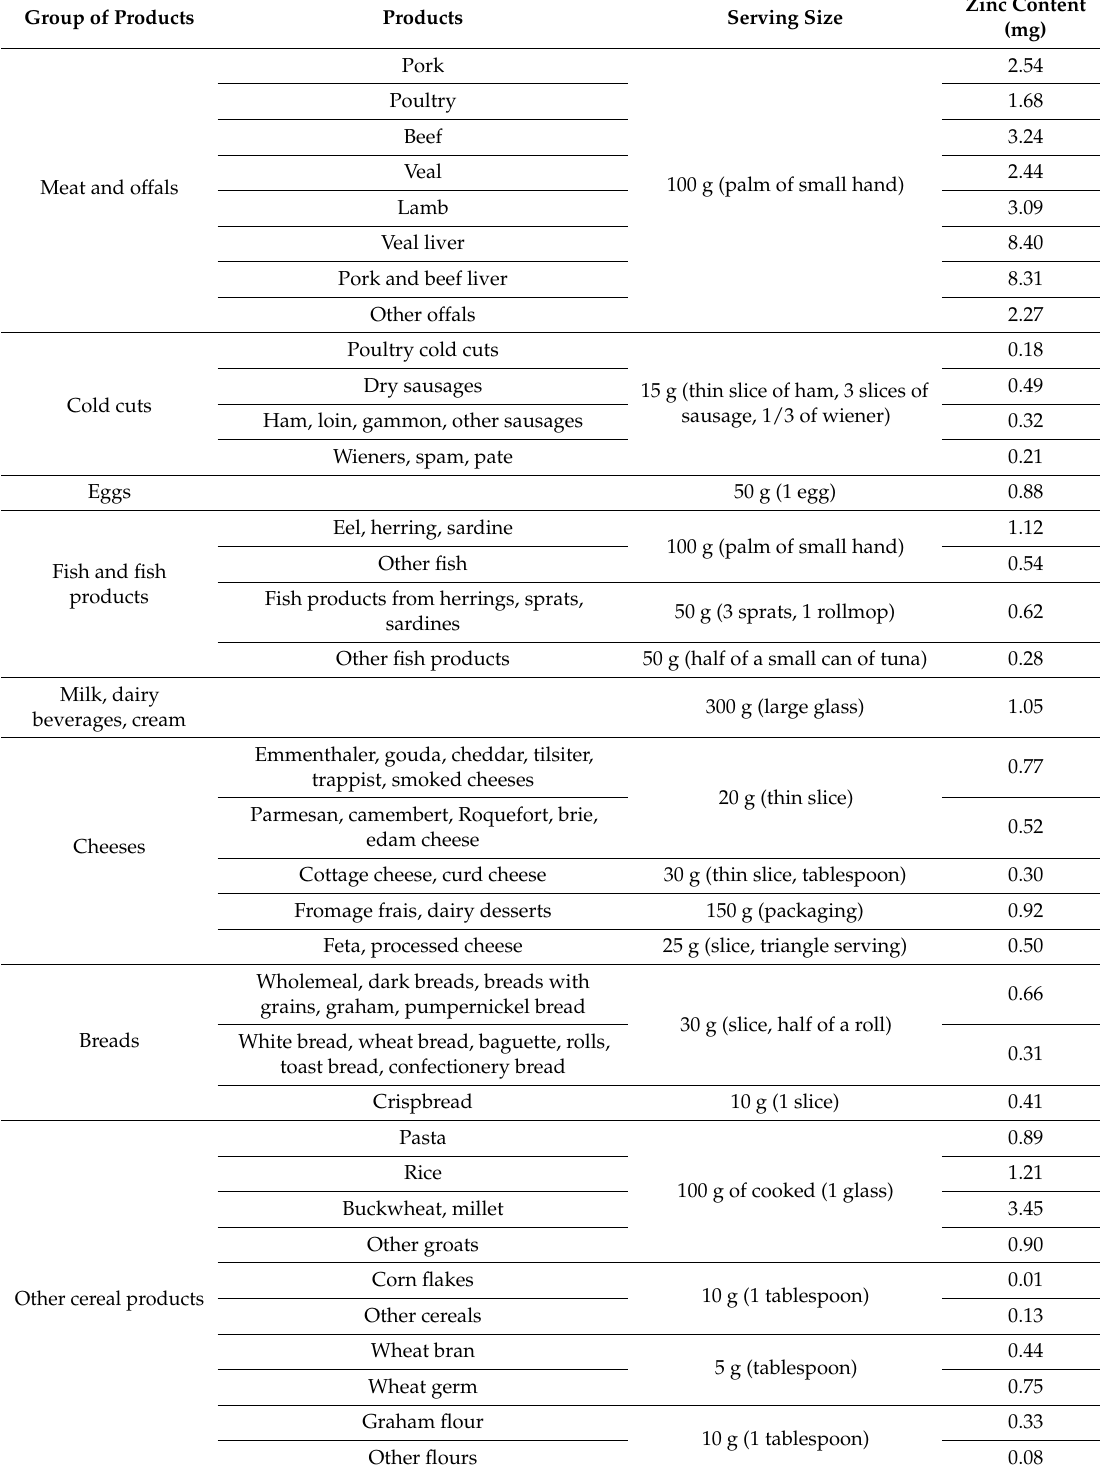
Table 2. The designed ZINC - FFQ calculation